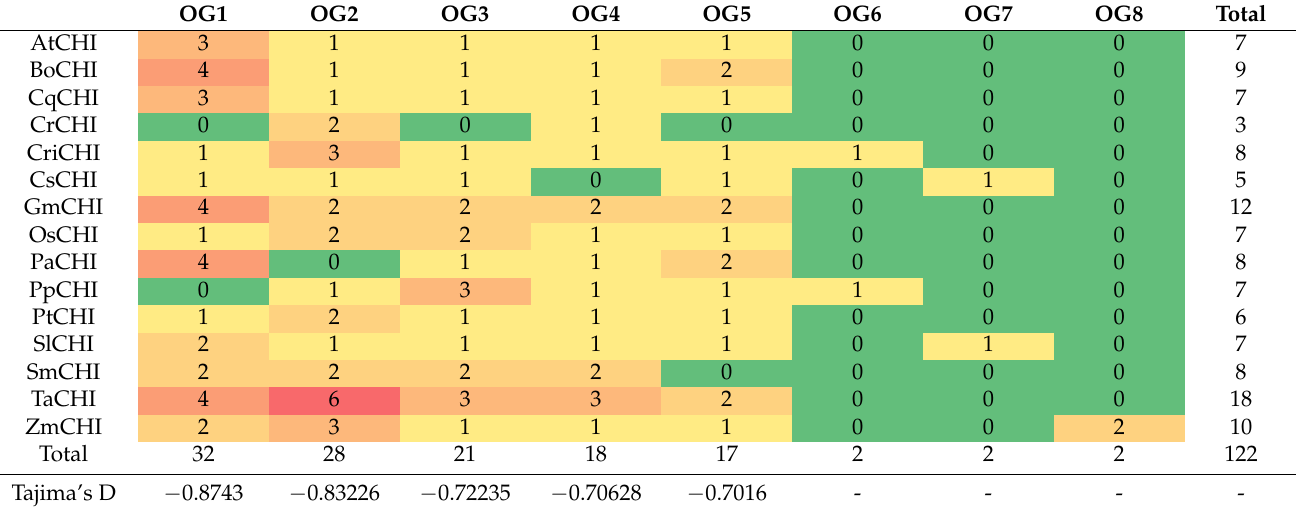
OG—orthologous group. Colors from green to red in table represent the number of genes of OGs in individual plants from lower to higher. Os, Zm, Ta, At, Bo, Cq, Cr, Cs, Gm, Pp, Pt, Sl, Sm, and Cri represent Oryza sativa , Zea mays , Triticum aestivum, Arabidopsis thaliana , Brassica oleracea , Chenopodium quinoa , Chlamydomonas reinhardtii , Cannabis sativa , Glycine max , Physcomitrella patens , Populus trichocarpa , Solanum lycopersicum , Selaginella moellendorffii and Ceratopteris richardii